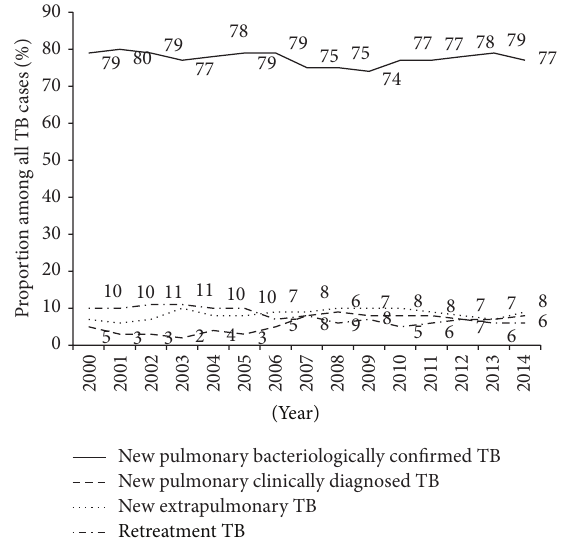
Figure 2: Different types of tuberculosis diagnosed in Benin, 2000– 2014.